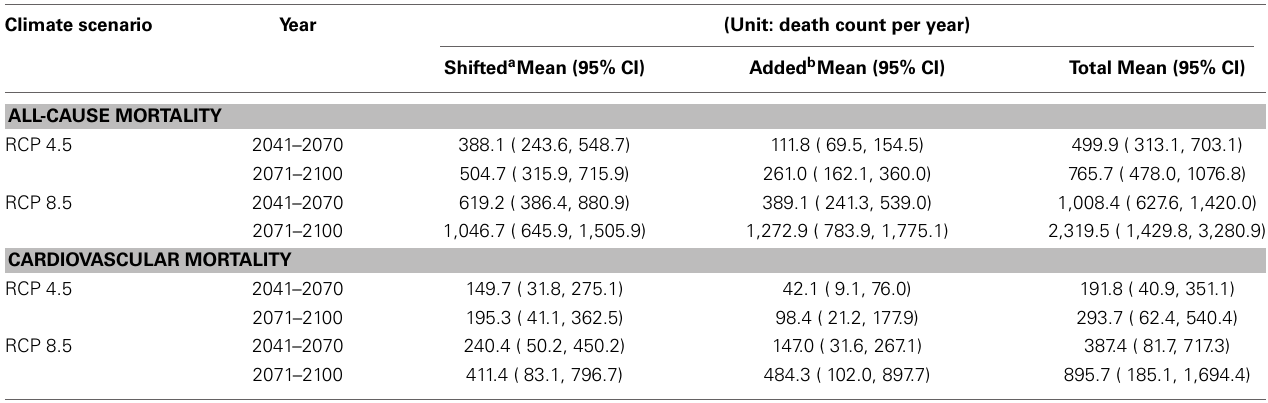
Table 4 | Excess mortality attributable to climate change-induced temperature increase in six cities, South Korea. Climate